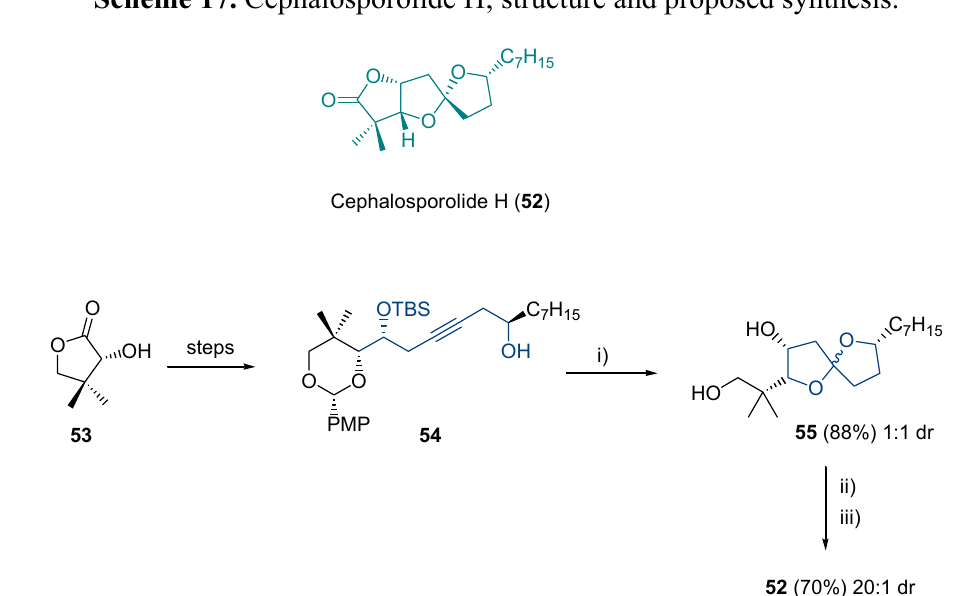
Scheme 17. Cephalosporolide H; structure and proposed